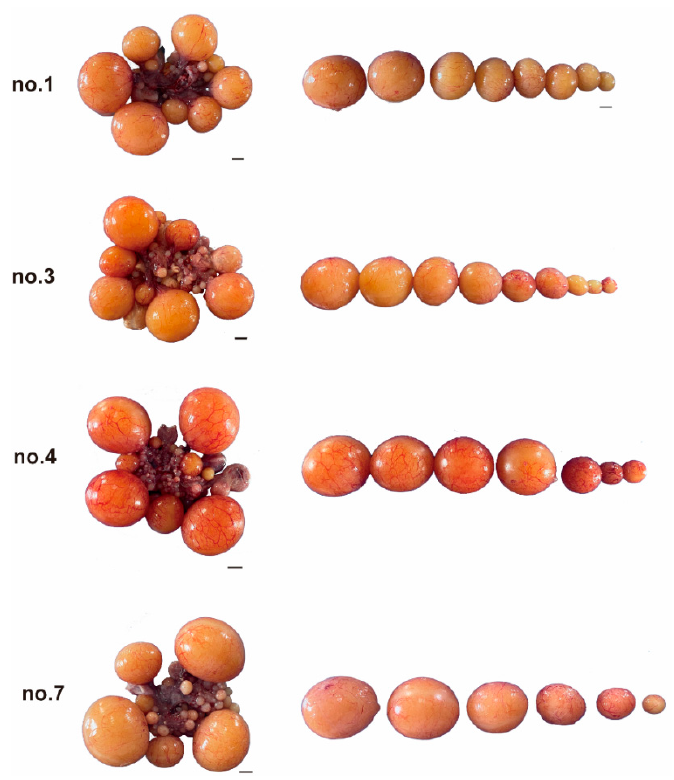
Figure 2. Morphology of ovary and follicle during the first clutch of egg-laying. Scale = 1 cm.